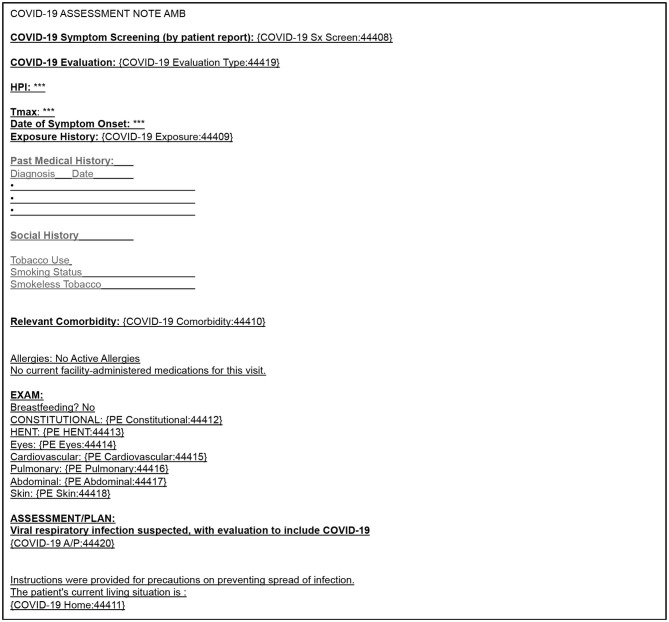
COVID-19 assessment ambulatory note template to accompany video visit encounters.